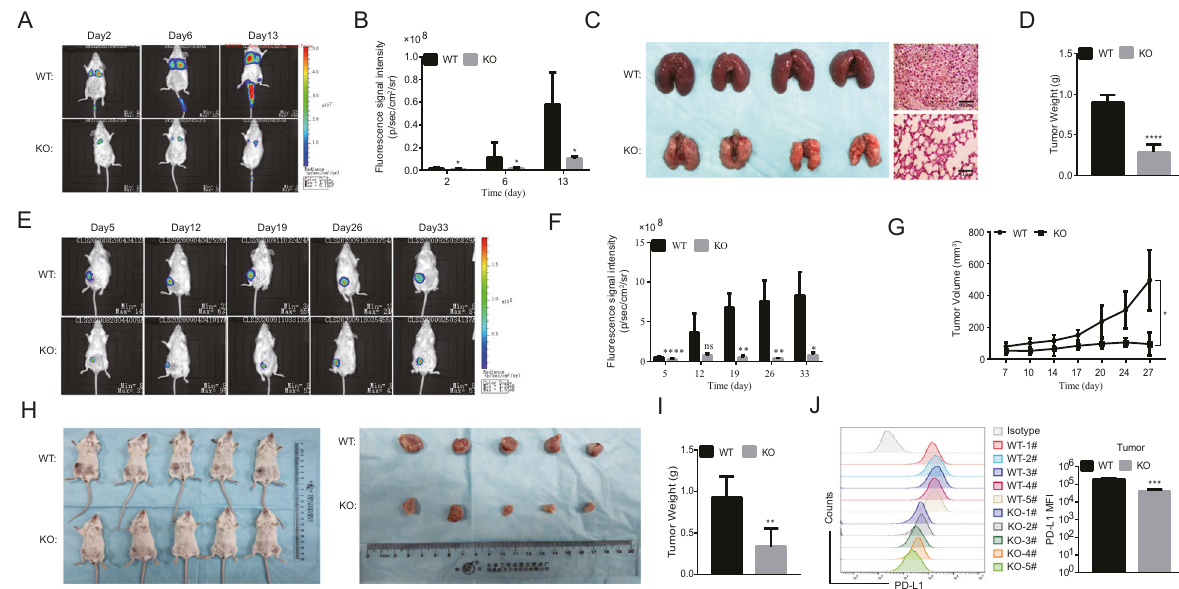
Fig. 5 HDAC2 knockout impaired tumor growth and PD – L1 production in vivo. A Representative whole-body luminescent images of mice taken at different times after WT and HDAC2-KO cells were intravenously injected into Balb/c mice. B Average lung signal intensities of fi ve mice-injected cells. The measurements were performed at the indicated time points ( n = 5). C, D The mice were sacri fi ced at the 13th day after cell injection, and tumor growth was monitored by gross morphology, H&E staining ( C ), and lung weight ( D , n = 5). E , F Similar to A and B , but 3 × 10 6 cells were implanted into the breast fat pad of Balb/c mice. G Tumor volumes were calculated every 3 – 4 days after tumor cells ’ implantation ( n = 5). H , I Similar to C and D , but the mice were sacri fi ced at 33 days after tumor cells ’ inoculation ( n = 5). J PD-L1 expression was determined in tumors by fl ow cytometry ( n = 5).